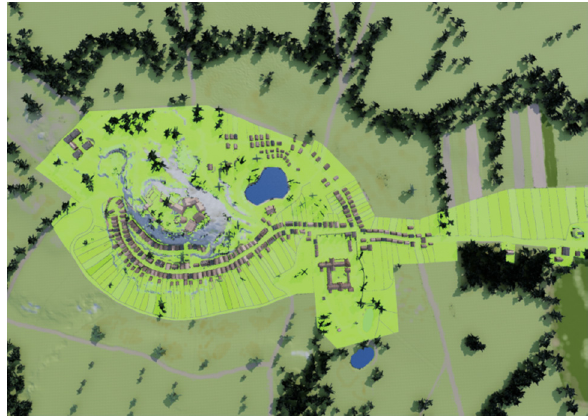
Figure 10. Overview of the 3D model historic town Segeberg and Gieschenhagen including the accessible area of the model (coloured in light green) and the area borders which follow obstacles in the model such as fences, treelines or steep